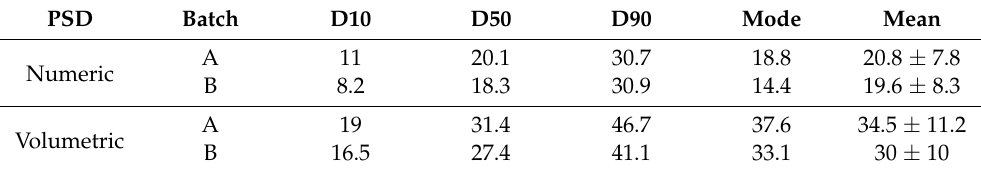
Figure 4. ( a ) Numeric and ( b ) volumetric particle size distributions (PSD). Table 4. Numeric and volumetric PSD measurements of the powder batches.